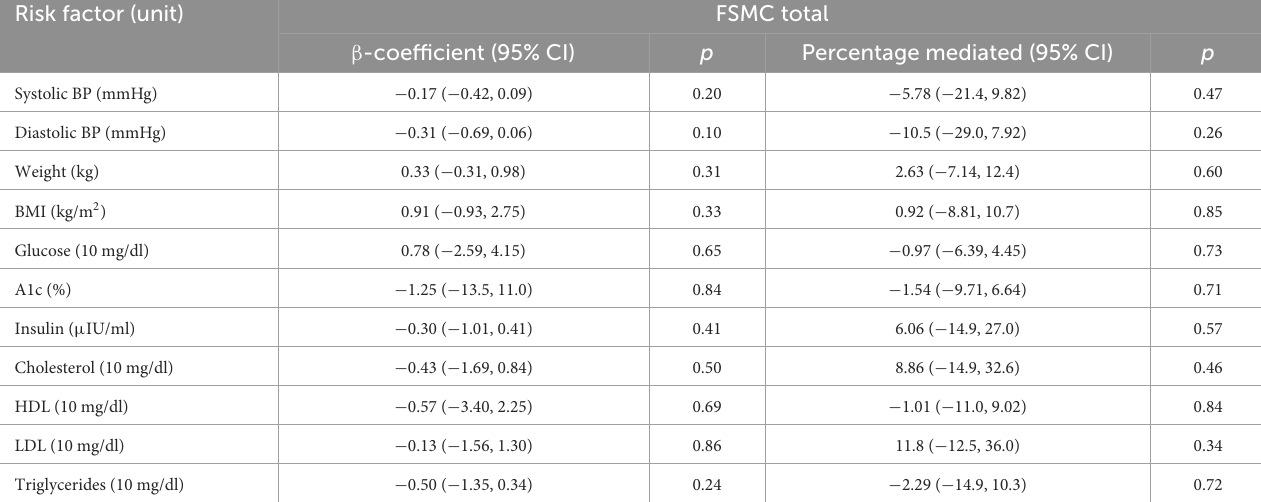
TABLE 3 Association and mediation effect of 12-week metabolic risk factor changes on perceived fatigue changes among participants with RRMS enrolled in a dietary intervention